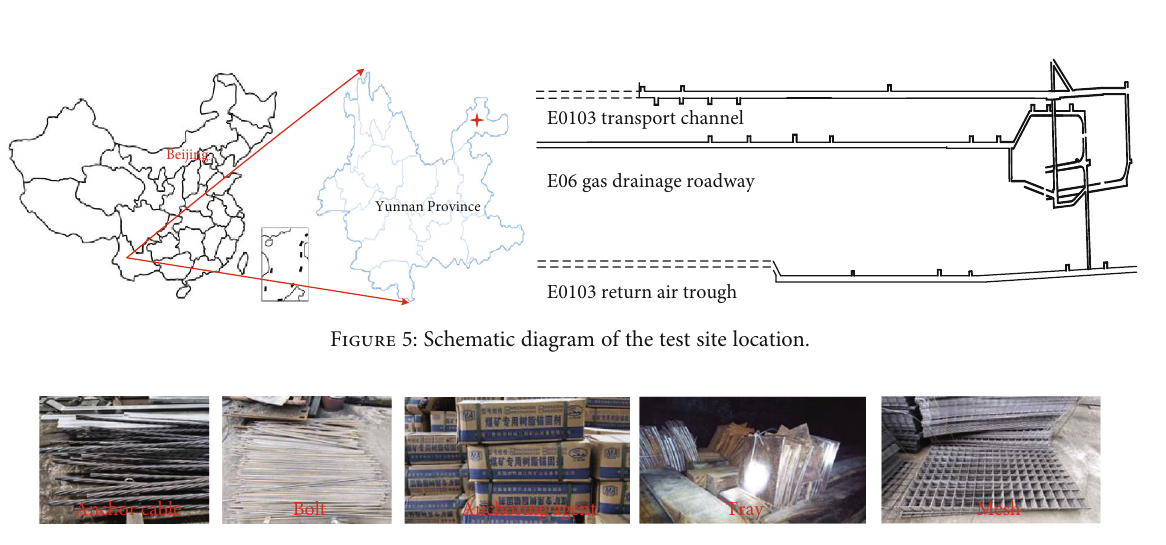
Figure 6: Materials used in the surrounding rock support system.